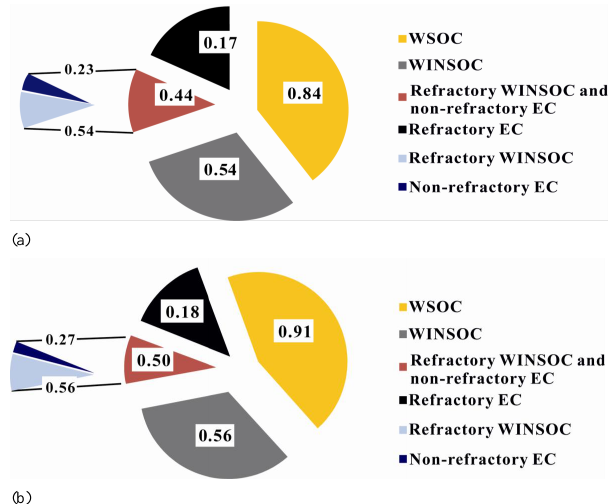
Fig. 10. Fig. 10. Composition of different carbonaceous particle fractions (pies) and f M values (numbers) in G¨oteborg for winter (GOT2) (a) and summer (GOT3) (b)